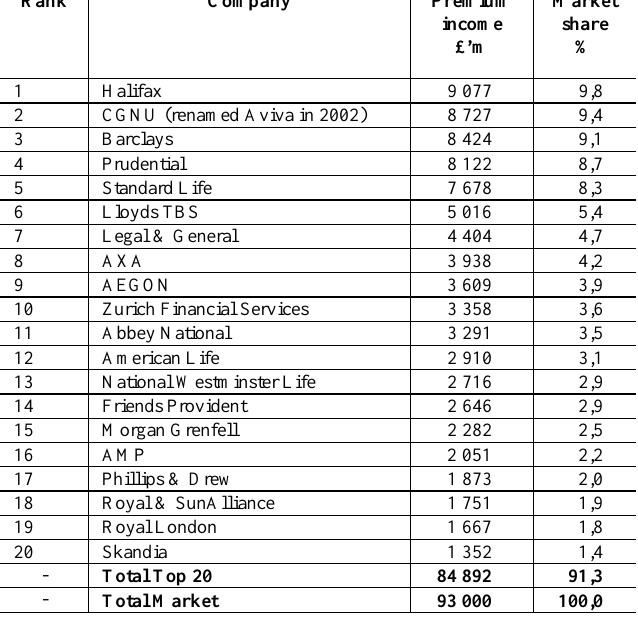
Table 1: 2001 top 20